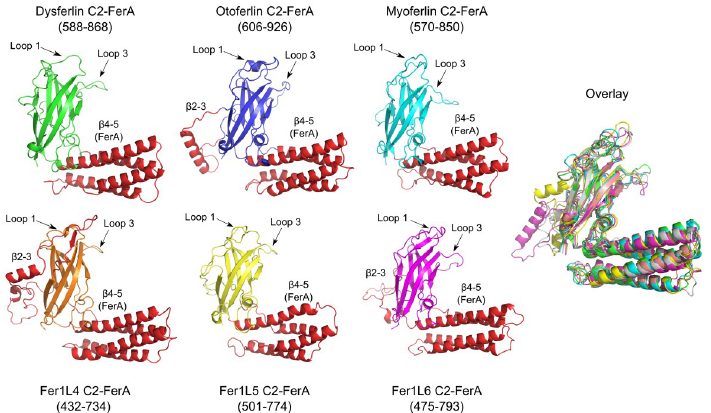
Fig 6. C2-FerA models for dysferlin C2-FerA (green), otoferlin C2-FerA (blue), myoferlin C2-FerA (cyan), Fer1L3 C2-FerA (orange), Fer1L5 C2-FerA (yellow), Fer1L6 C2-FerA (magenta). The FerA subdomain ( β 4–5) is shown as red α -helices, as is the β 2–3 subdomain unique to Type-2 ferlins. The superposition of all six C2-FerA models is labeled as ‘Overlay’.